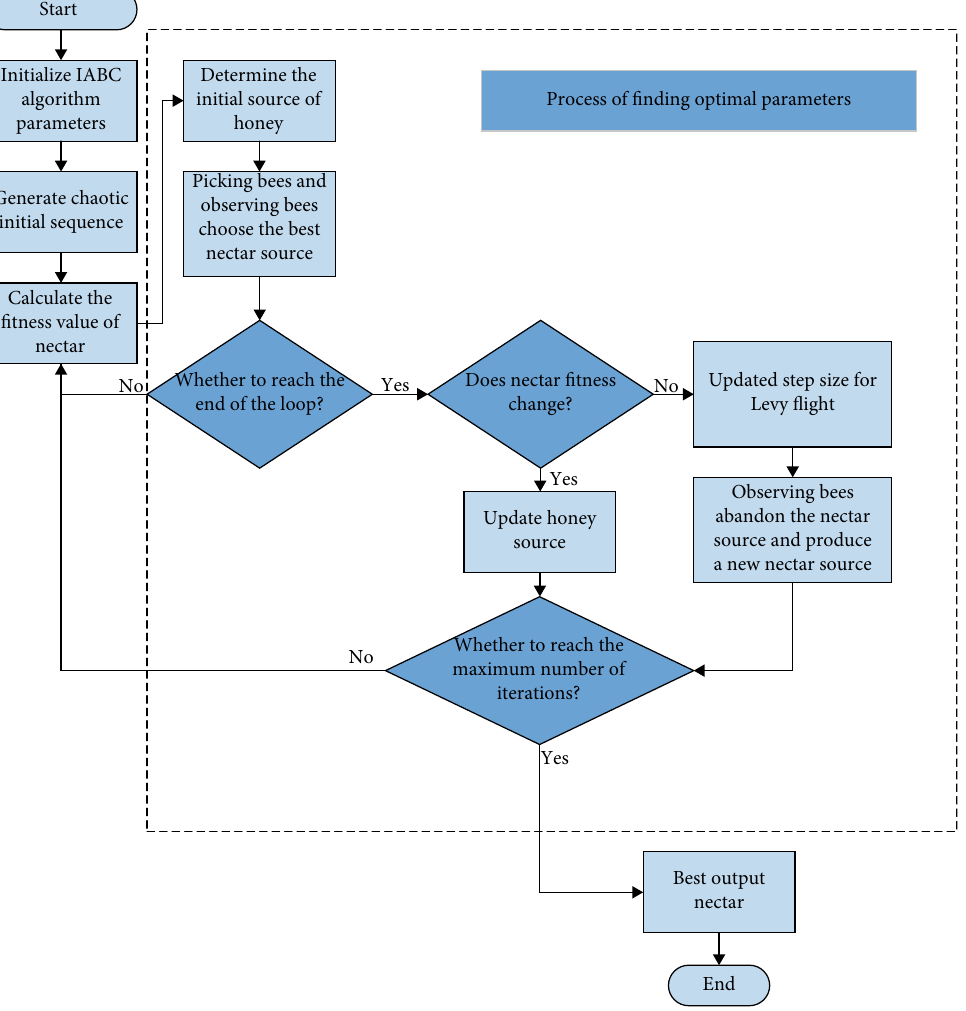
Figure 8: Based on the improved IABC-WLSSVM algorithm fl